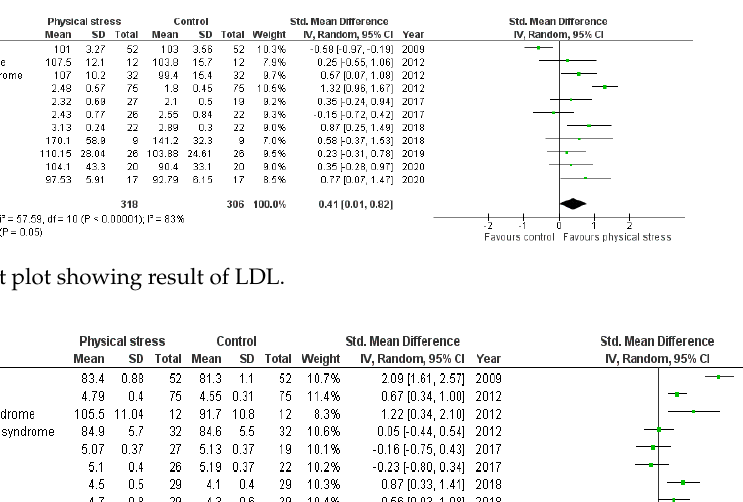
Figure 8. Forest plot showing the results for blood glucose.